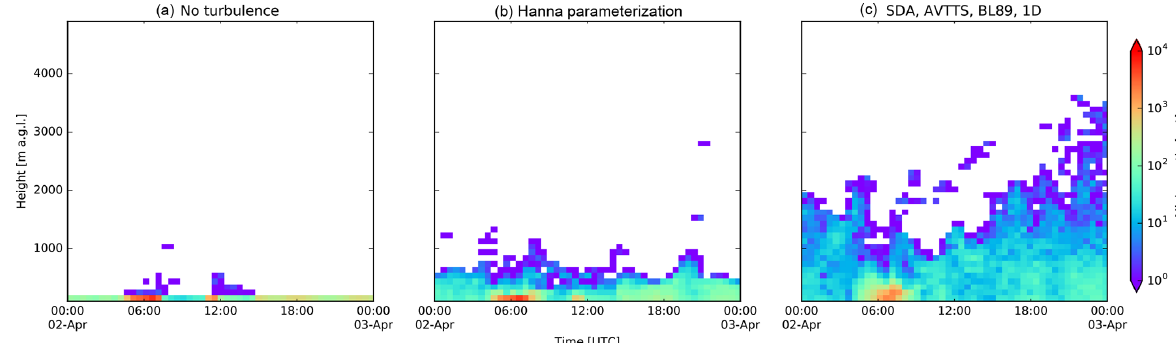
Figure 7. Marine boundary layer tracer profile evolution above the sea. Panel (a) : a simulation without turbulent motions taken into account. Panel (b) shows the traditional FLEXPART turbulent mode. Panel (c) shows the results with the new turbulent mode. Table 1. Computation time ratios relative to the original Hanna parameterization computation time. Well- Point Marine TURB_ mixed release boundary Turbulent configuration OPTION test test layer run No turbulent motion 0 0.96 2.30 1.89 Hanna parameterization 1 1.00 1.00 1.00 WRF: hybrid mode with TKE and Hanna 2 0.94 1.18 x WRF: TKE with stable repartitioning 3 1.12 1.32 x DELTA 10 4.95 1.06 x AVTTS BL89 11 4.89 1.06 x DEARDORFF 12 6.81 1.06 Step TKE DELTA 20 4.95 FVTTS BL89 DEARDORFF DELTA AVTTS BL89 DEARDORFF SDA DELTA FVTTS